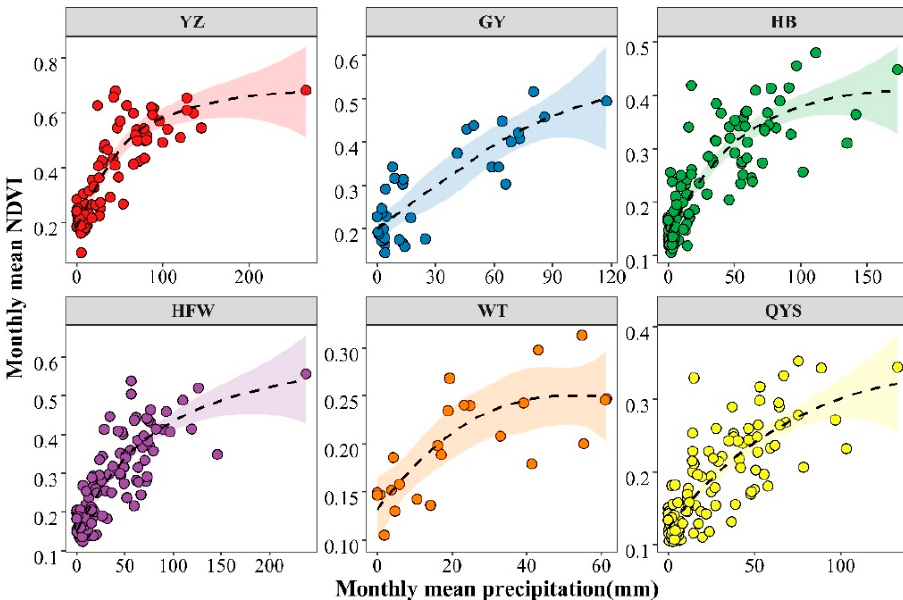
Figure 9. Relationships between monthly mean precipitation and NDVI.